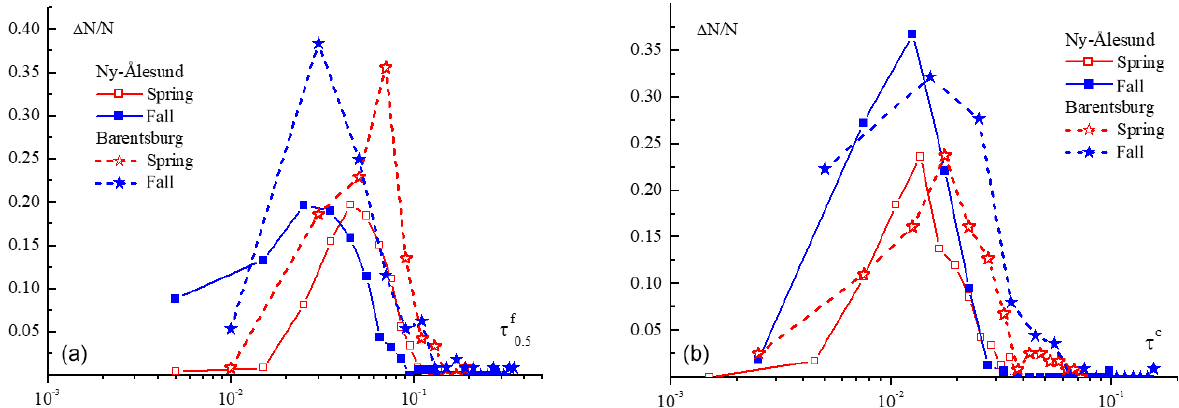
Figure 12. Frequency histograms of (a) τ f